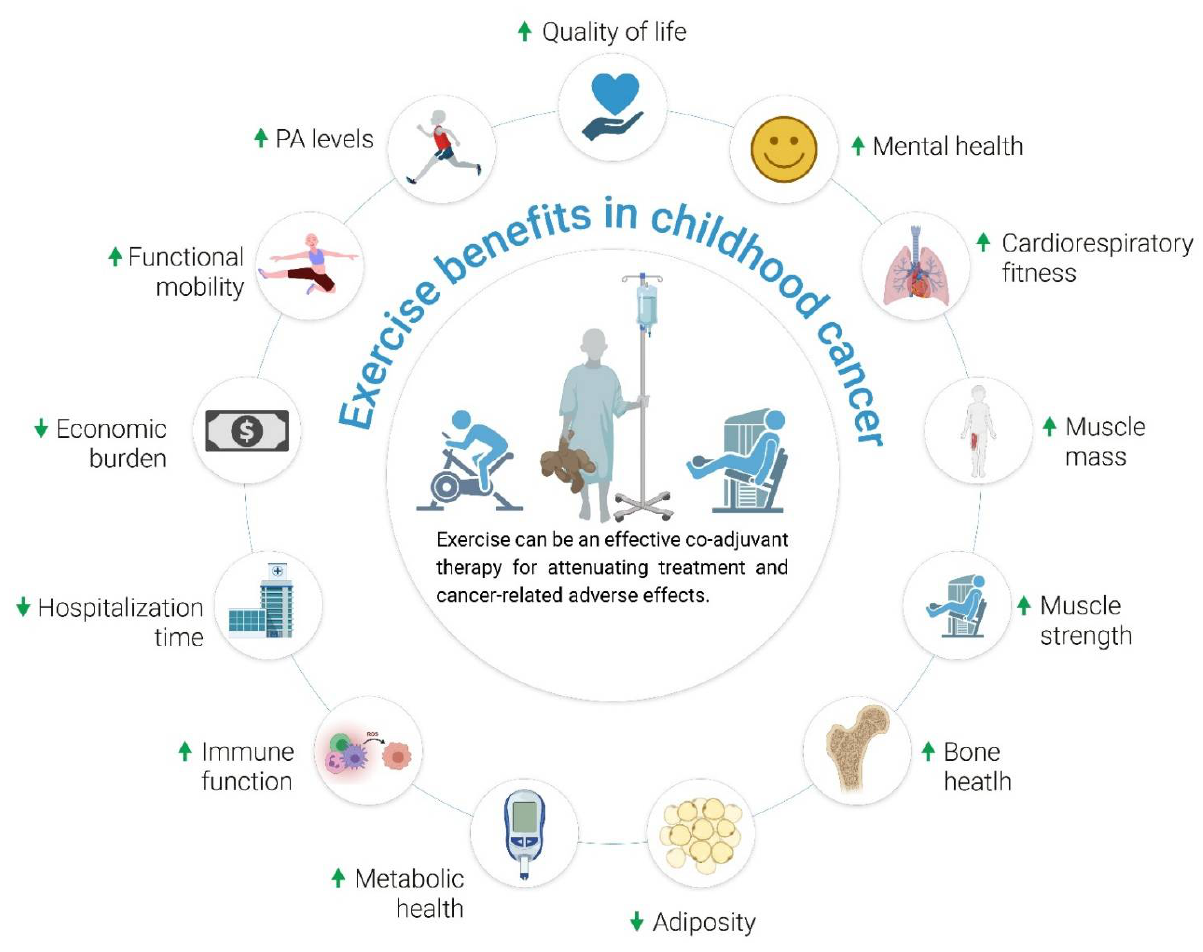
Figure 2. Potential exercise benefits in childhood cancer. Source: self-elaboration. Of note, strong evidence (e.g., based on meta-analyses) is still needed for some of the potential benefits, such as a decrease in hospitalization time or an actual decrease in adiposity (including central adiposity).